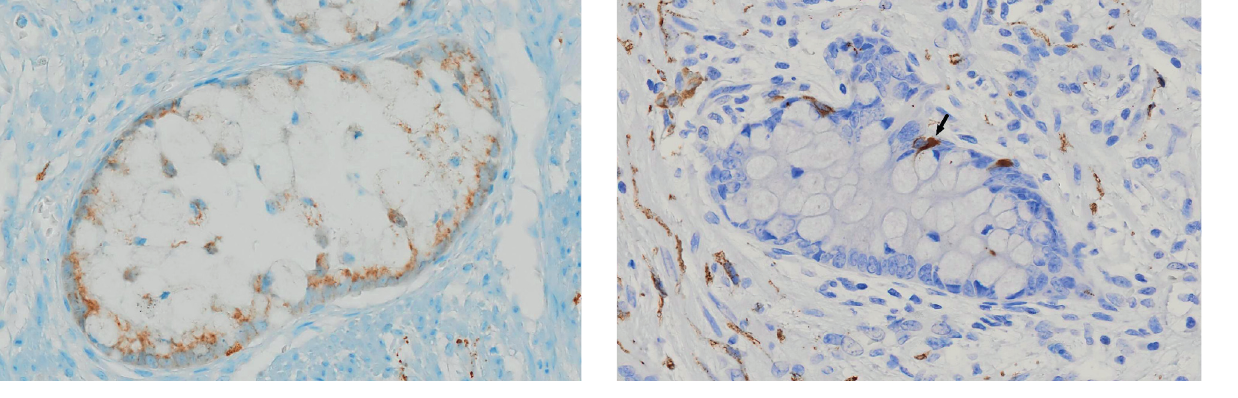
Fig. 5a. Comparison with a synaptophysin-positive focus of GCC (case No. 7) (synaptophysin, 200x).